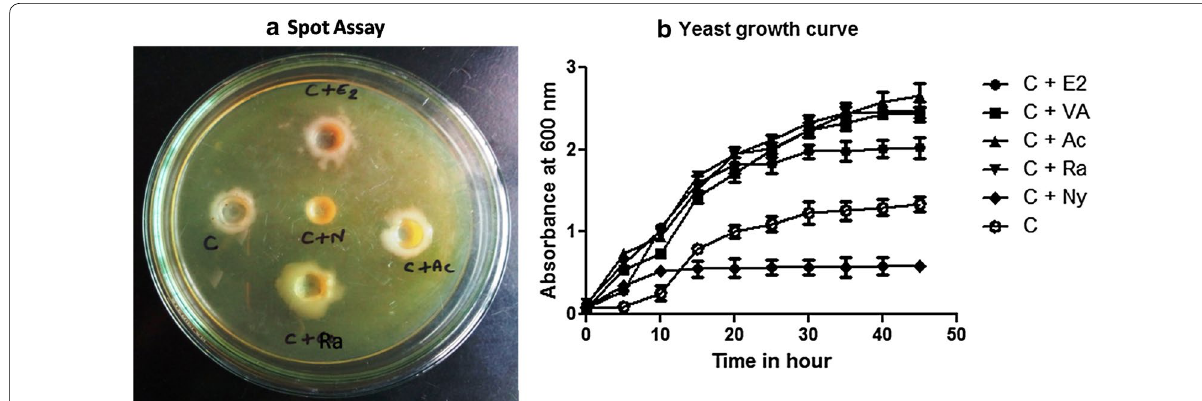
Fig. 7 In vitro spot assay of anti-aging activity of the crude extract of secondary metabolites of Talaromyces purpureogenus isolate- ABRF2. S. cerevisiae BY4742 cells spotted onto YPD plates. Growth curve for the S. cerevisiae BY4742 strain were measured in YPD medium. p < 0.05 indicated a significant difference. Fungal extract and their growth spots generated during spot assay along with control systems using S. cerevisiae BY4742. C—culture only ( S. cerevisiae BY4742); C E2—culture and extract of isolate ABRF2 ; C N—culture and fluconazole (nystatin) as negative control; + + C VA—culture and n -valeric acid; C Ac—culture and acarbose and C Ra—culture and rapamycin as positive + + +